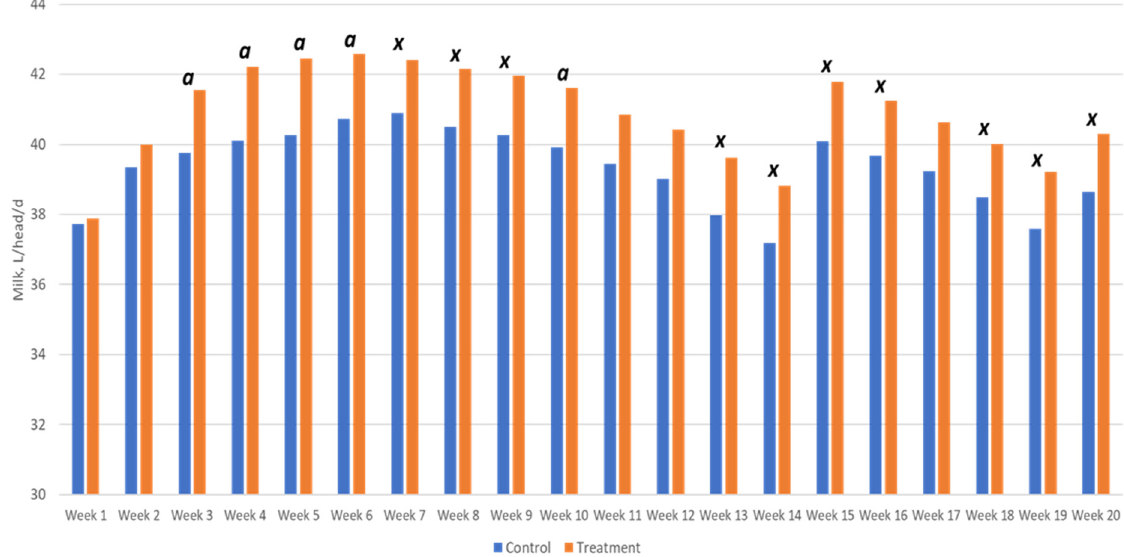
Figure 1. Average weekly milk production in the two groups (a = p -value ≤ 0.05; x = p -value ≤ 0.1). Table 3. Production performance: milk quality analyses.